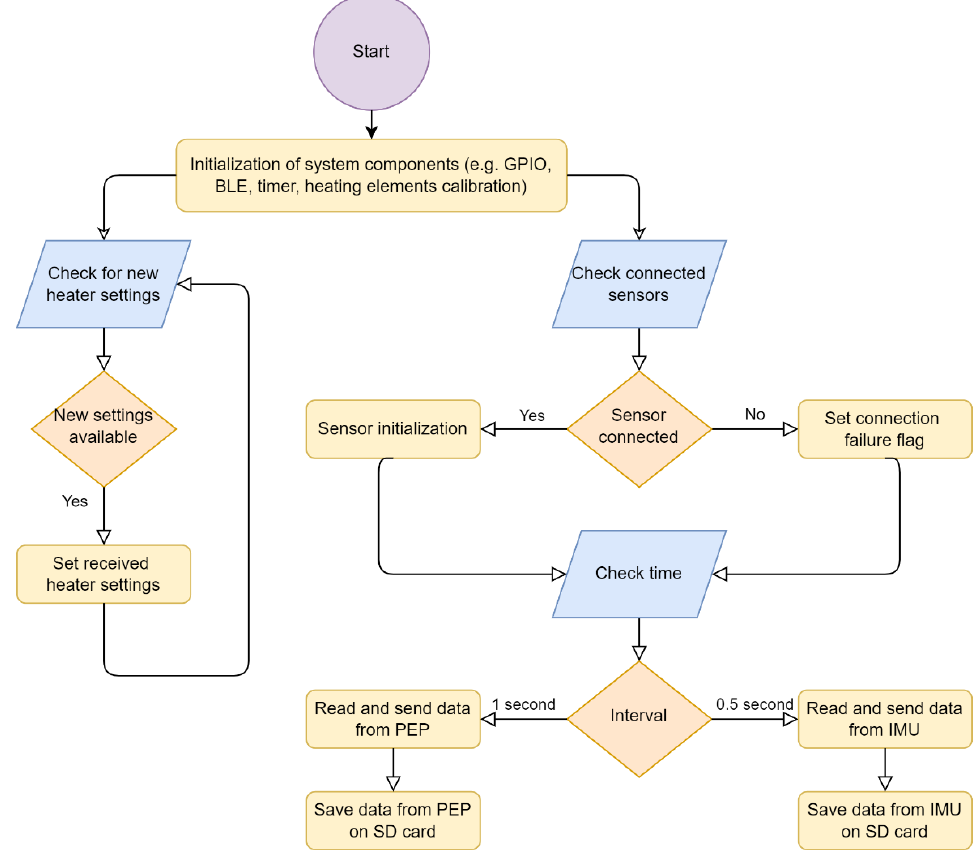
Figure 2. Block diagram of the algorithm of the control module.